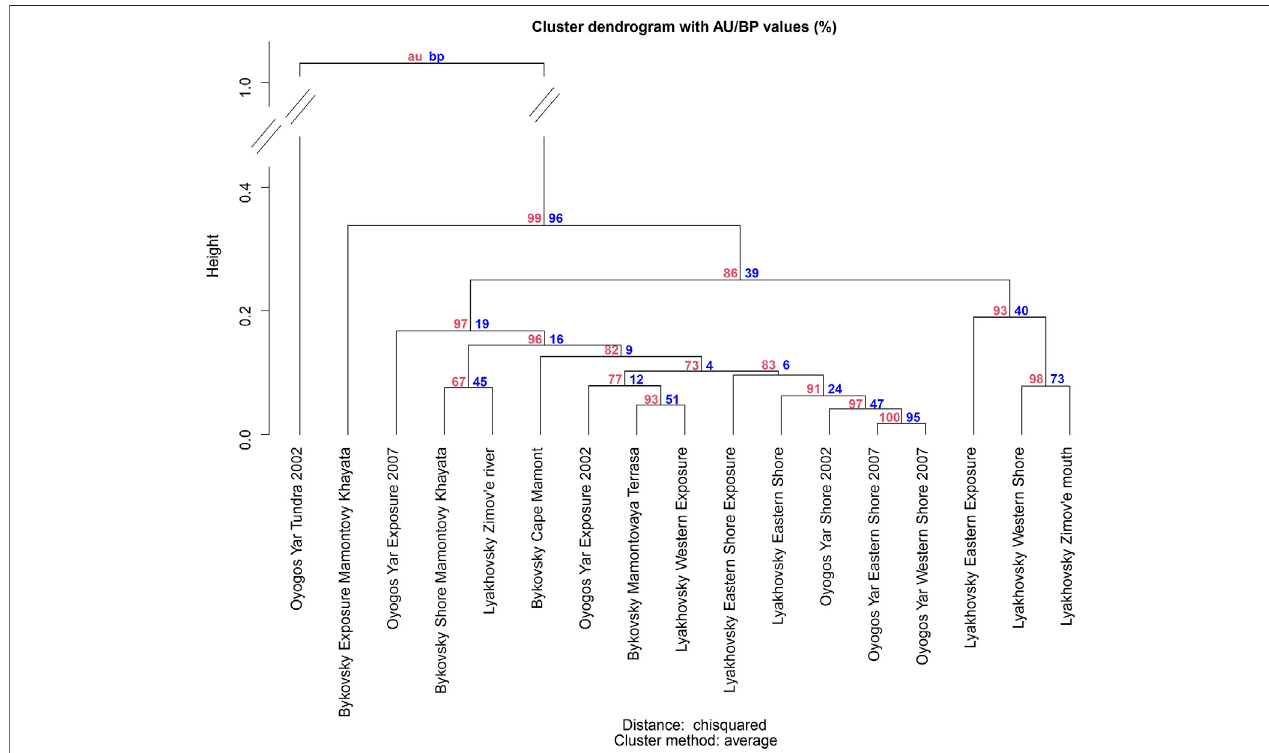
FIGURE 10 | Cluster dendrogram for the hierarchical clustering of mammoth fauna species bone counts for all sampling sites. Distances are assessed using the chi-squared method. Clustering method is “ average. ” Numbers at the dendrogram edges are for basic bootstrapping probability signi fi cance values (red) and corrected approximately unbiased signi fi cance values (green), statistical signi fi cances according to the bootstrapping approach used in